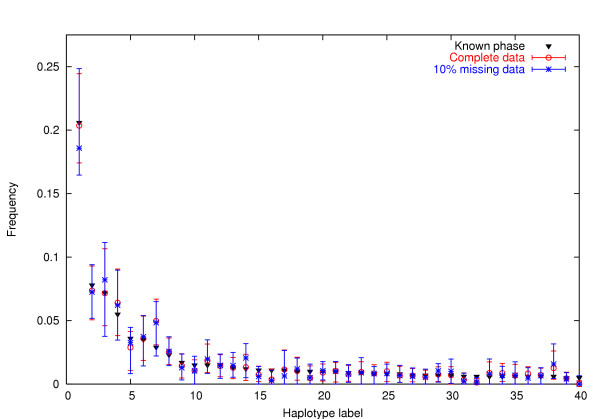
Multiallelic data with 10% missing alleles. 95% CIs for haplotype frequencies estimated from multiallelic phase-unknown data with 0% and 10% missing data. Frequencies derived from phase-known data also shown.